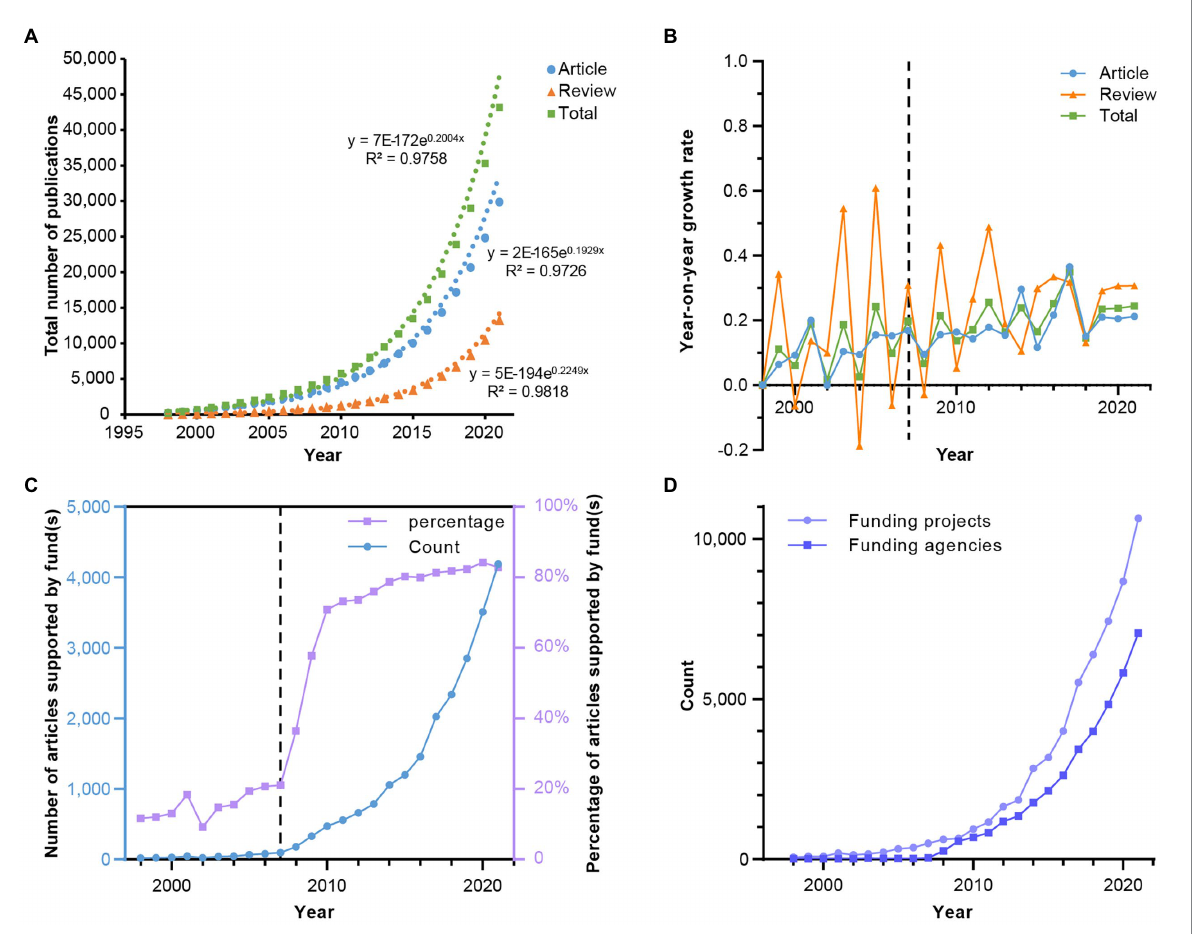
FIGURE 1 The trend of publications and funding in the research field of gut microbiome and disease. (A) The cumulative number of publications in each year and their exponential regressions. (B) The year-on-year growth rate of publications. (C) The number and percentage of funded articles. (D) The number of funding agencies and projects each